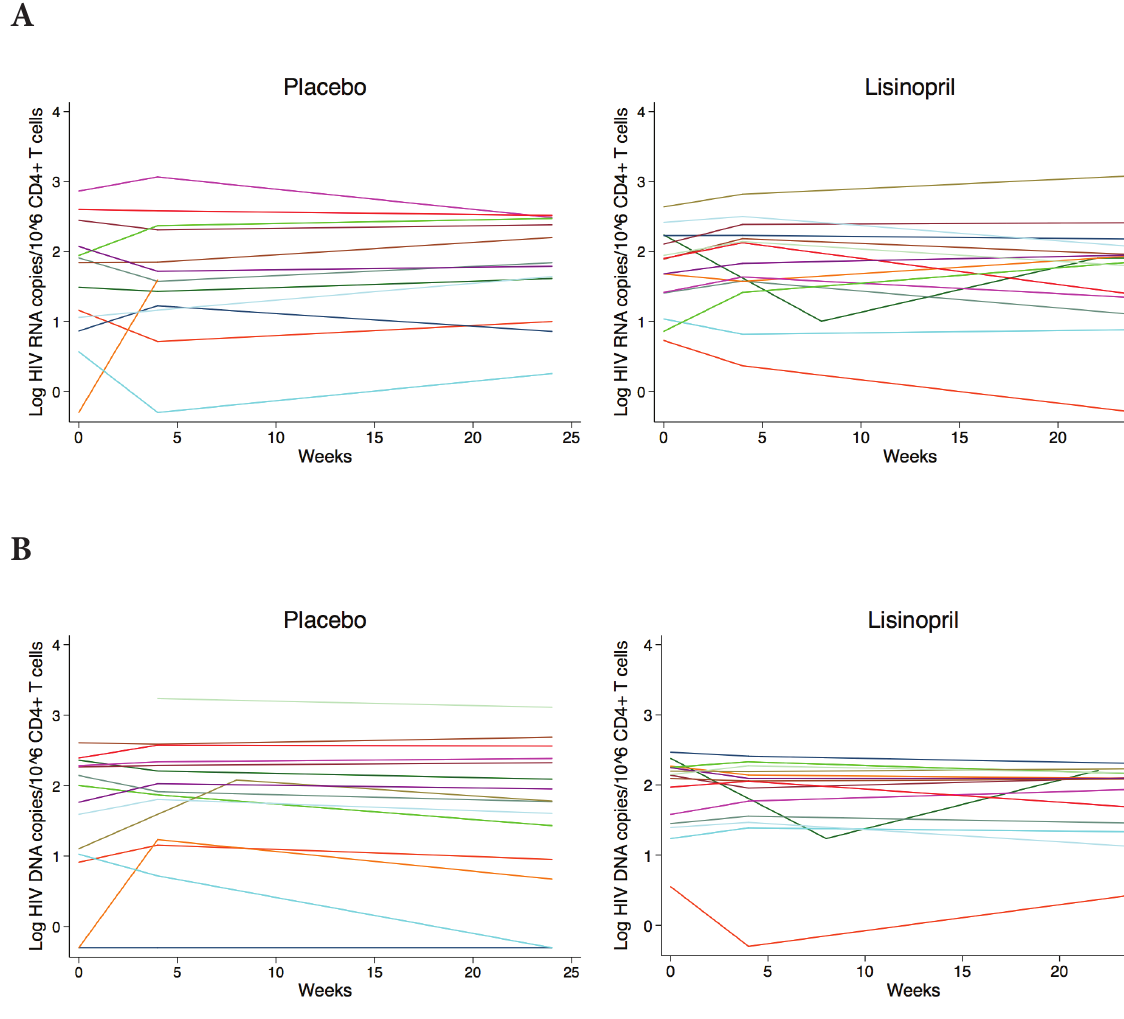
Figure 2. Change in Log HIV RNA copies/per 10 6 CD4 + T cells (A) and Log HIV DNA copies copies/per 10 6 CD4 + T cells from Week 0 to Week 24 in the placebo and lisinopril treatment